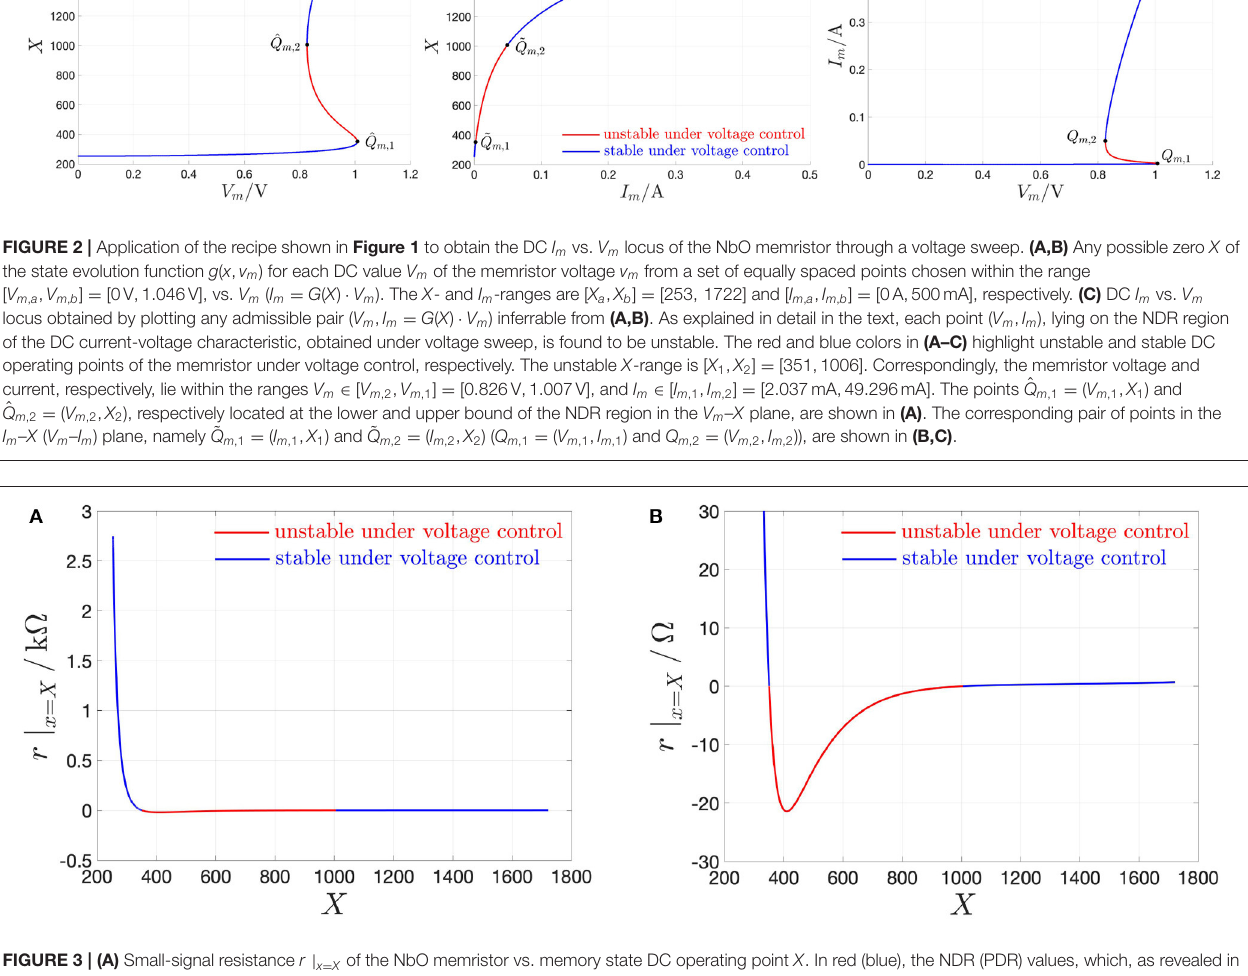
of the NbO memristor vs. memory state DC operating point X . In red (blue), the NDR (PDR) values, which, as revealed in | x = X r , defined in Equation (16), and denoting the largest modulus of the device ˆ 411, and is equal to 21.43 (cid:127) . Another state bias point of significance for the remainder of this manuscript is = 16.514 (cid:127) . − two possible operating points. For V m 0.875 V, the SDR, = drawn in red in plot (A), crosses the memory state axis in three points, specifically X l 289, X 612, and X r 1, 456, of = = = which each of the outer ones (of which the center one) are locally stable (is unstable), given that d ˙ x dx (cid:12)